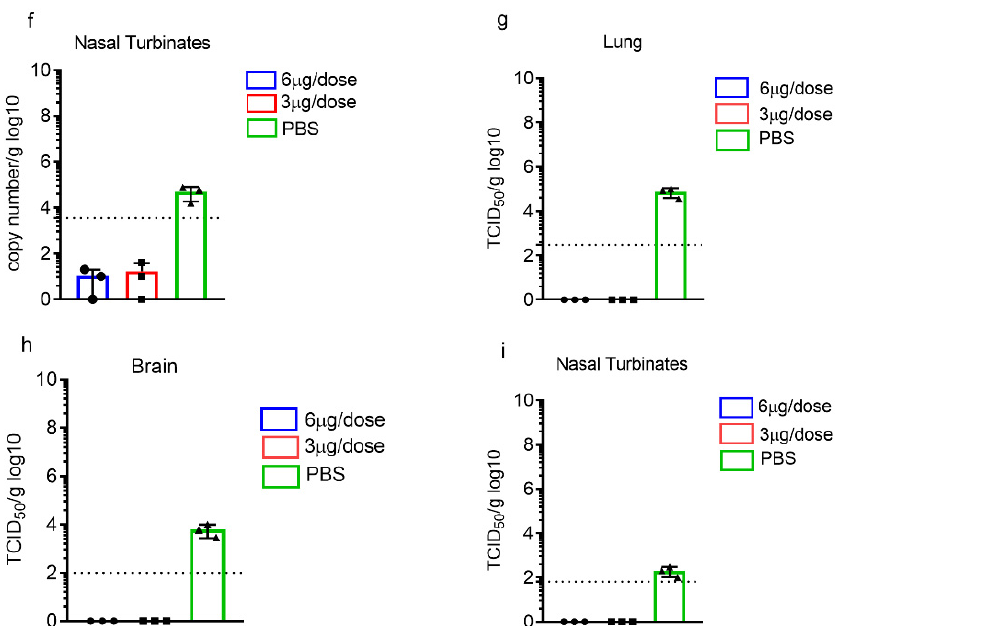
Figure 3. Protective efficacy of ERUCoV-VAC in K18-hACE2 transgenic mice. ( a ) Scheme of sample collection, immunization regimens, and SARS CoV-2 challenge. Groups of K18-hACE2 transgenic mice immunized on days 0 and 21 with doses of 3 µ g ( n = 13) or 6 µ g ( n = 10) of ERUCoV-VAC or with a placebo ( n = 13) via the intraperitoneal route. The K18-hACE2 mice ( n = 10 per group) were challenged at 2 weeks after the second immunization with 5 × 10 4 TCID50 of SARS-CoV-2 in a volume of 60 µ L by the intranasal route. Bodyweight ( b ) and survival ( c ) were evaluated according to the indicated timeline. The K18-hACE2 transgenic mice that lost ≥ 25% of their initial body weight were humanely euthanized. On day 3 after the challenge, three K18-hACE2 transgenic mice in each group were euthanized, and lungs, brains, and nasal turbinates were collected for qPCR and virus titration via TCID50 assay. qPCR was performed by targeting viral N gene for lungs ( d ), brains ( e ), and nasal turbinate ( f ) using a Diagnovital real-time PCR kit. A standard curve was generated using a viral RNA. Ten-fold dilutions of viral RNA were prepared, and negative control samples were included in each assay. The Ct value for each sample was converted into log 10 viral copies/g tissue according to the standard curve. The dotted line indicates the highest value measured in the normal control group, which were 2.16 log10, 1.75 log10, and 3.35 log10 N copy number/g in the lungs, brains, and nasal turbinates, respectively. Live virus titres of the lungs ( g ), brains ( h ), and nasal turbinates ( i ) were determined via TCID50 assay at day 3 post-challenge. The statistical significance was assessed using a two-way ANOVA test, and p values less than 0.01 were considered to be statistically significant where ** denotes 0.01. Error bars represent mean ± standard